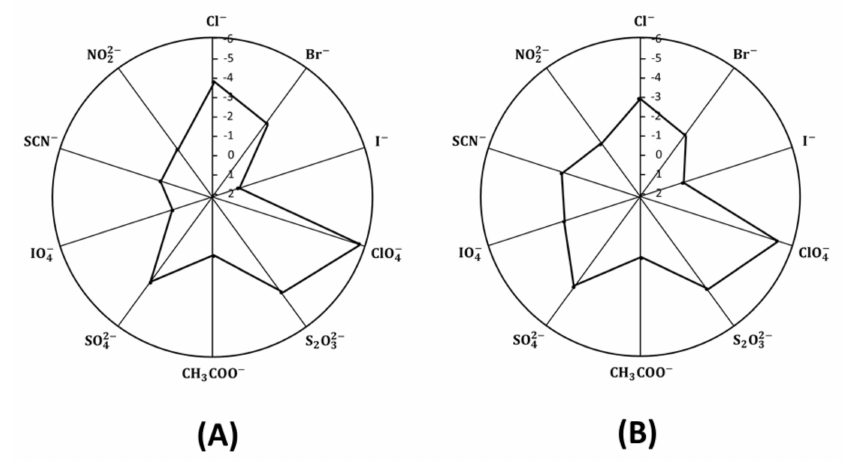
Figure 6. Selectivity coe ffi cient diagrams of: ( A ) paper and ( B ) ceramic based chromium(VI) sensors with PANI solid contact using the modified separate solutions method